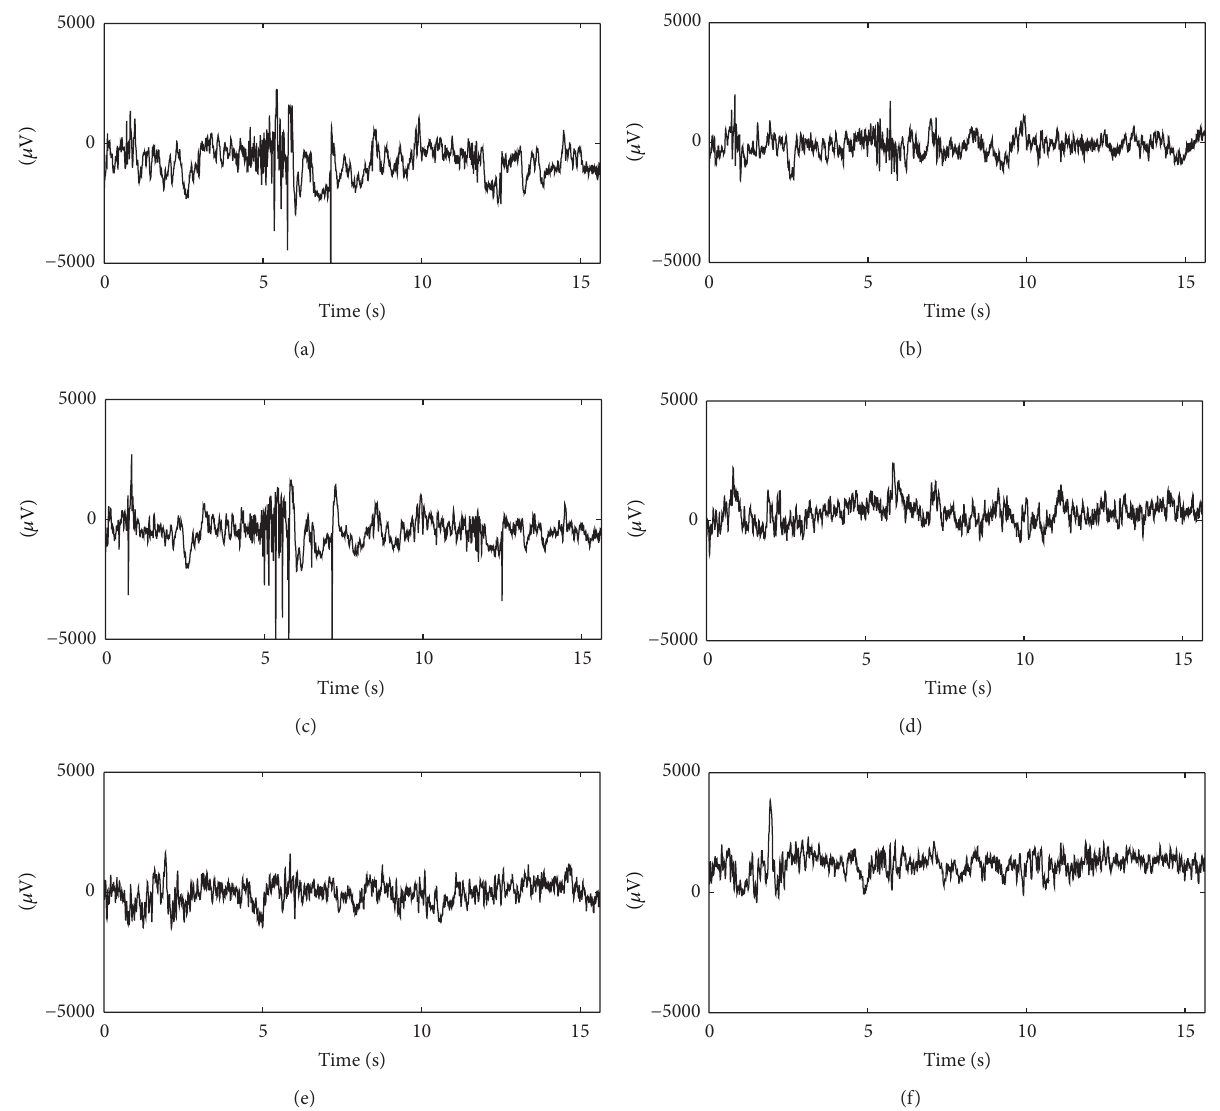
Figure 4: Examples of 6-channel epileptic EEG segments from patient 3 of Freiburg dataset. From top to bottom and left to right, they are channels 1–6,